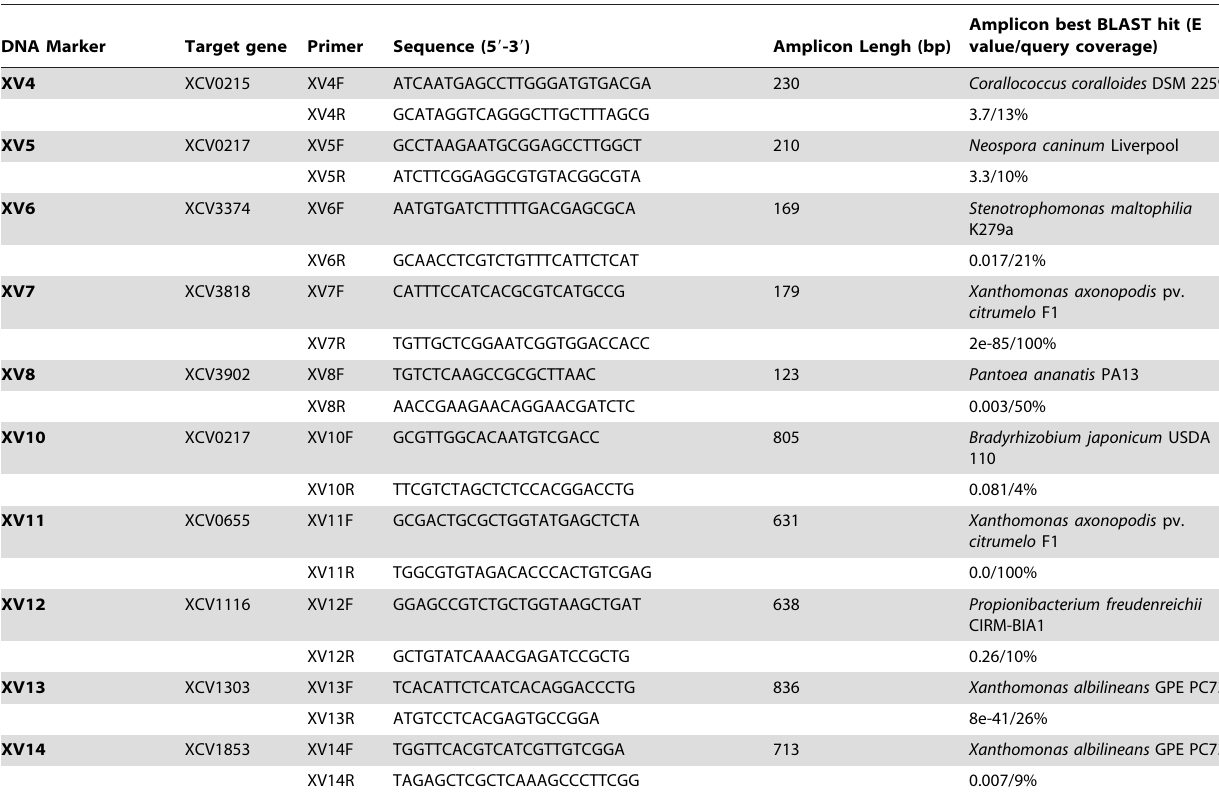
Table 1. Primer-pairs and best BLAST hits for the selected markers.